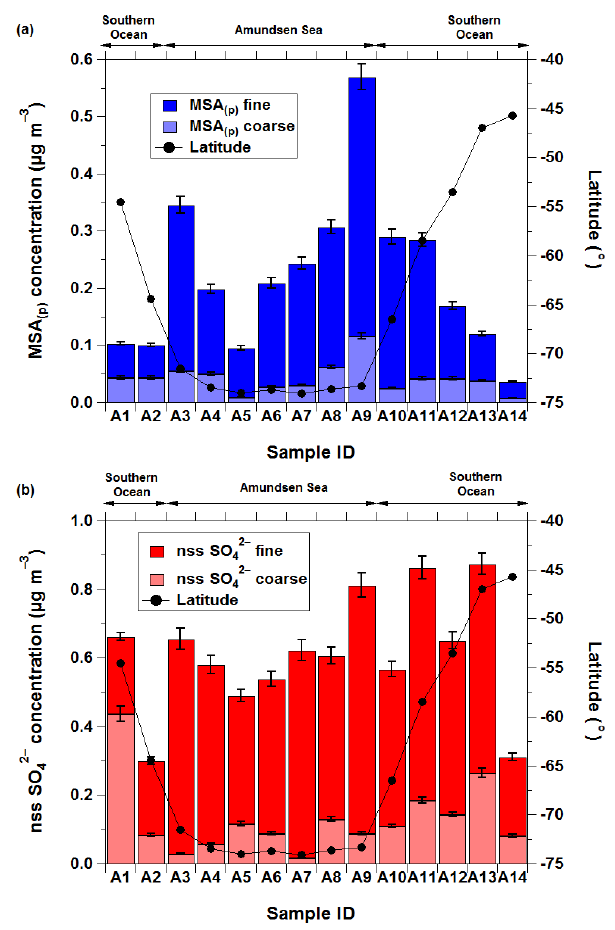
Figure 2. Concentrations of particulate methanesulfonic acid (MSA ( p ) ) (a) and non-sea-salt sulfate (nss SO 2 − ) (b) against sam- 4 ple ID in aerosols collected over the Southern Ocean (43–70 ◦ S) and the Amundsen Sea (70–75 ◦ S). The black solid lines with cir- cles indicate the latitude of the halfway point between each aerosol sampling start point and endpoint. Double arrows show the sam- pling locations of aerosol